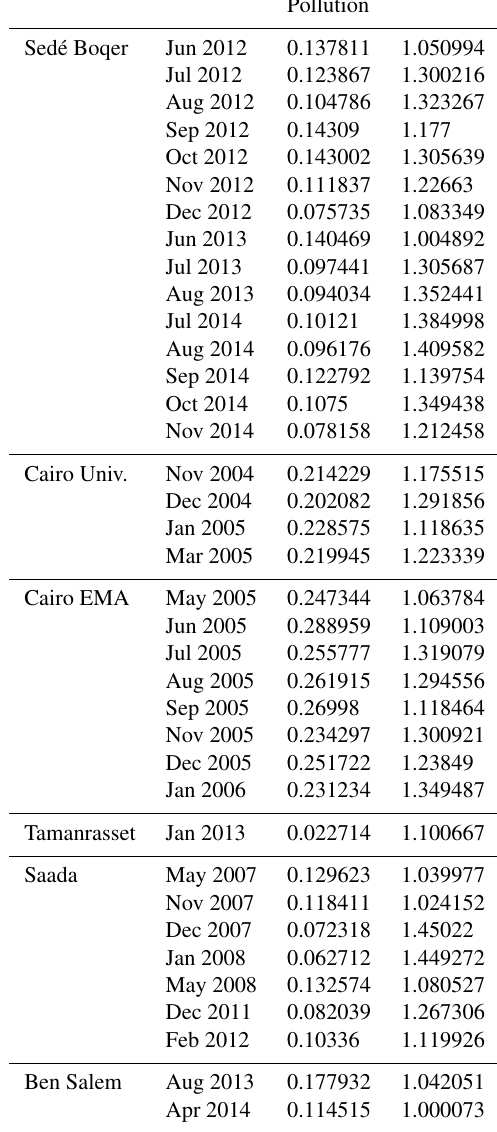
Table 5. Seasonal mixing particle domination over study